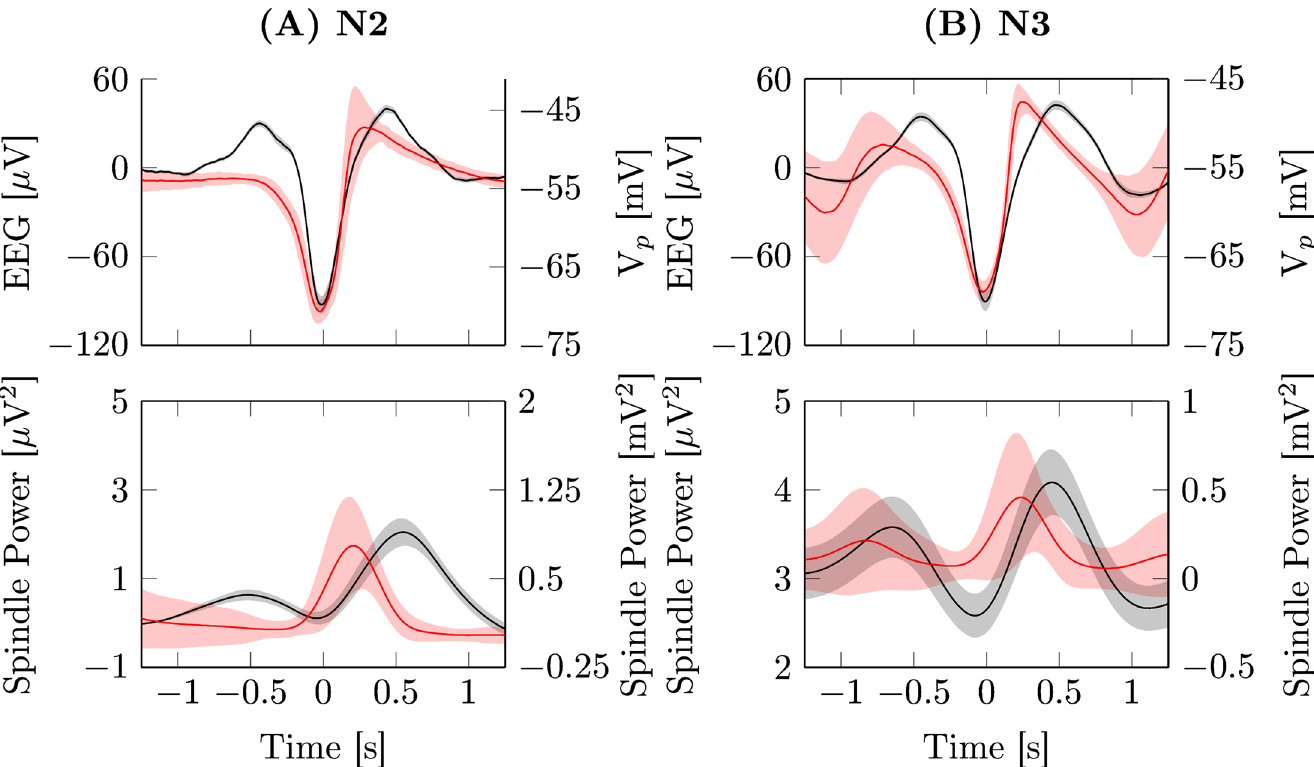
Fig 6. Event triggered average potentials. Averaged EEG signal (top) and fast spindle band power (bottom) time-locked to the negative peaks (t = 0 s) of all detected events from electrode Cz (black, left axis) and model output (red, right axis). (A) Detected KCs from data scored as sleep stage N2 (Experiment: 227,45 ± 19,22, Model: 238 events). (B) SO average from data scored as sleep stage N3 (Experiment: 983,64 ± 106,1, Model: 654 events). Each simulation was run for 3600 s with parameters set according to Table 2.